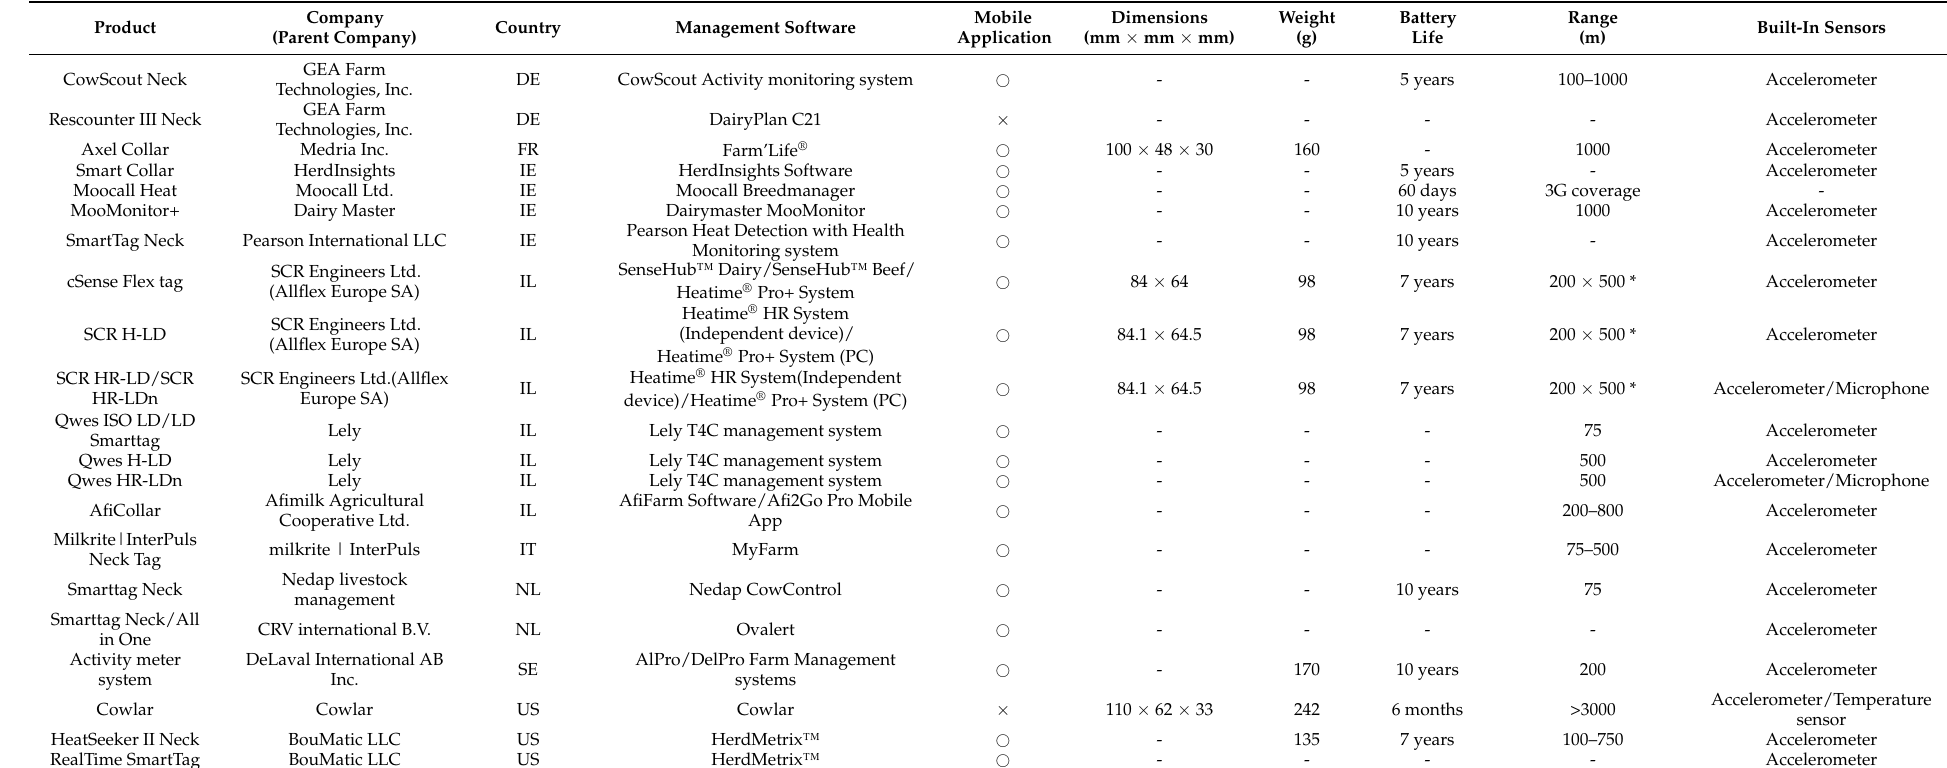
Table 3. Information about currently available neck collar type